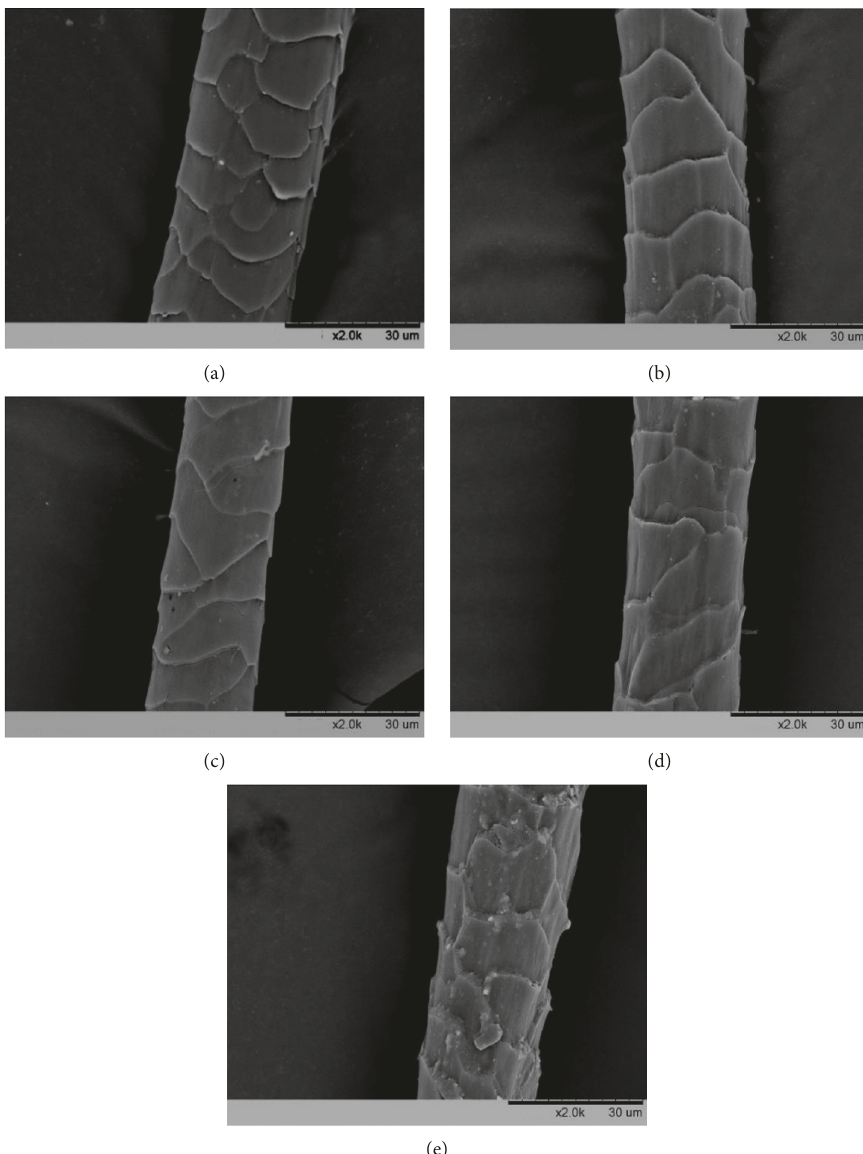
Figure 2: SEM micrographs of wool surfaces before and after treatment: (a) untreated wool fiber; (b) 3% protease/silver NPs at pH � 4; (c) 6% protease/silver NPs at pH � 4; (d) 9% protease/silver NPs at pH � 4; (e) 6% protease/silver NPs at pH �